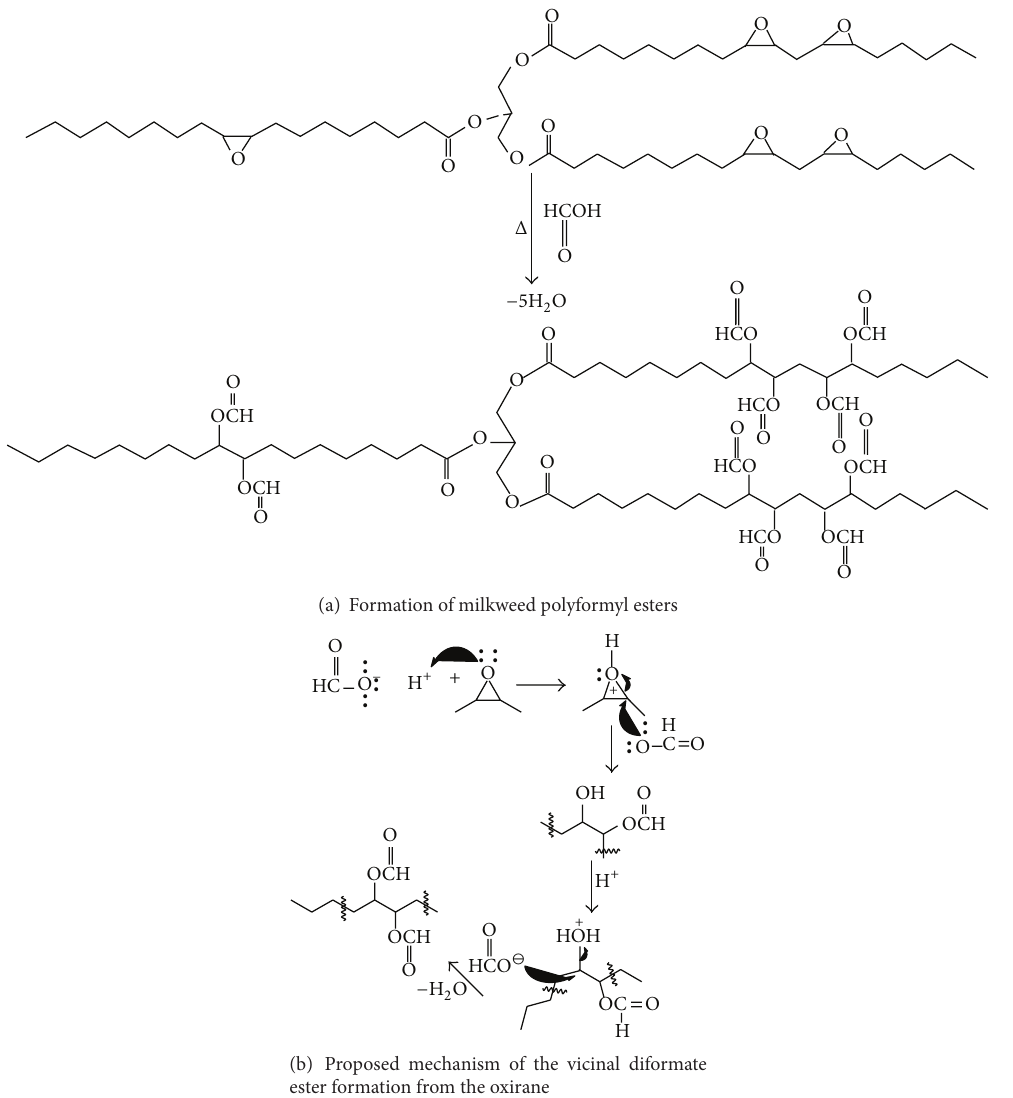
Figure 6: (a) Schematic of formation of polyformyl ester of milkweed oil from the oxirane; (b) proposed mechanism of the vicinal diformyl ester formation from the